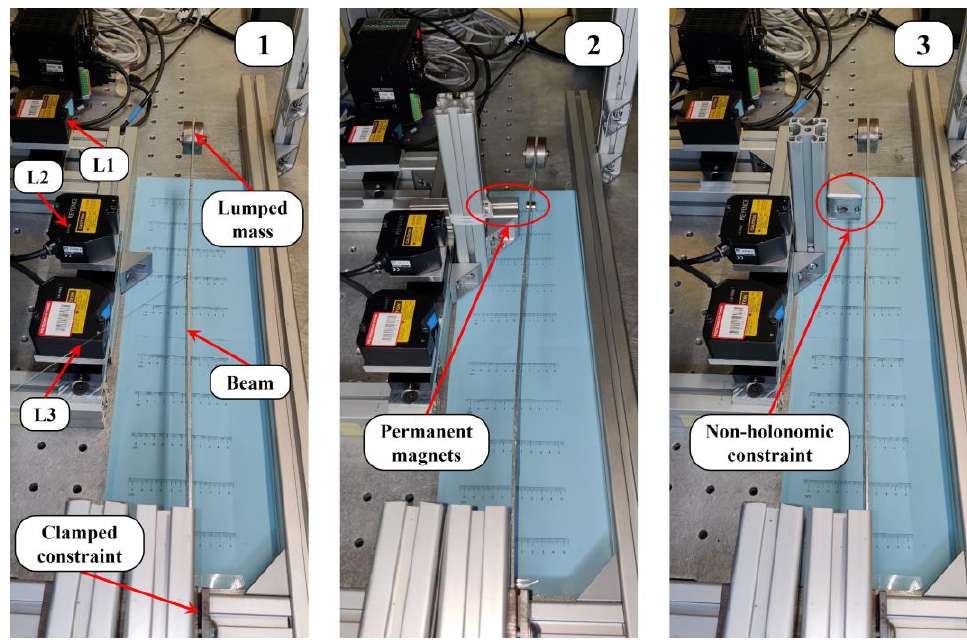
Figure 5. Overview of the experimental setups: clamped-free beam ( left ), beam with two pairs of permanent magnets acting in attraction or repulsion ( centre ), and beam with a non-holonomic constraint ( right ).